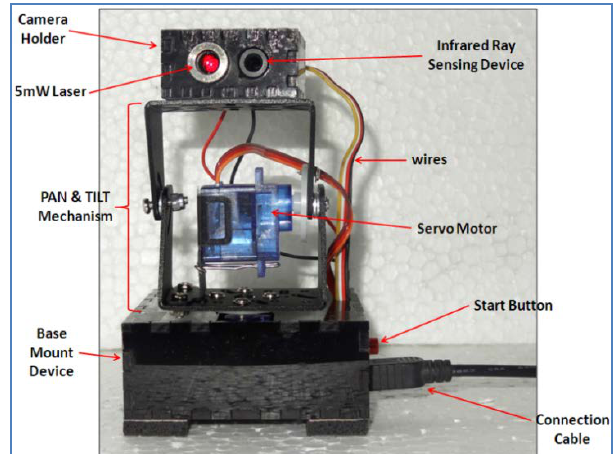
Figure 4. DAGSVM with event-calculus